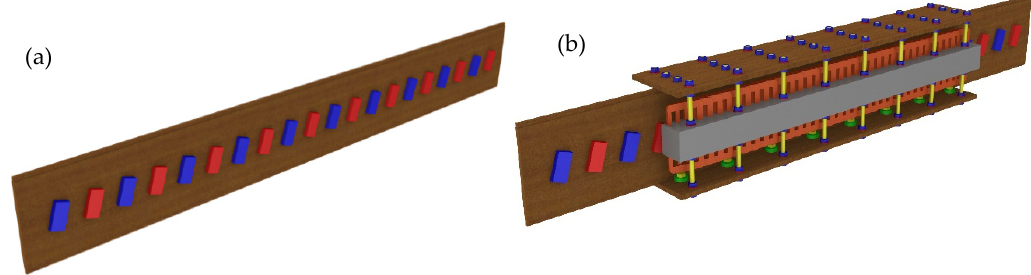
Figure 5. A translator view ( a ) and a 3D view of the entire system ( b ).